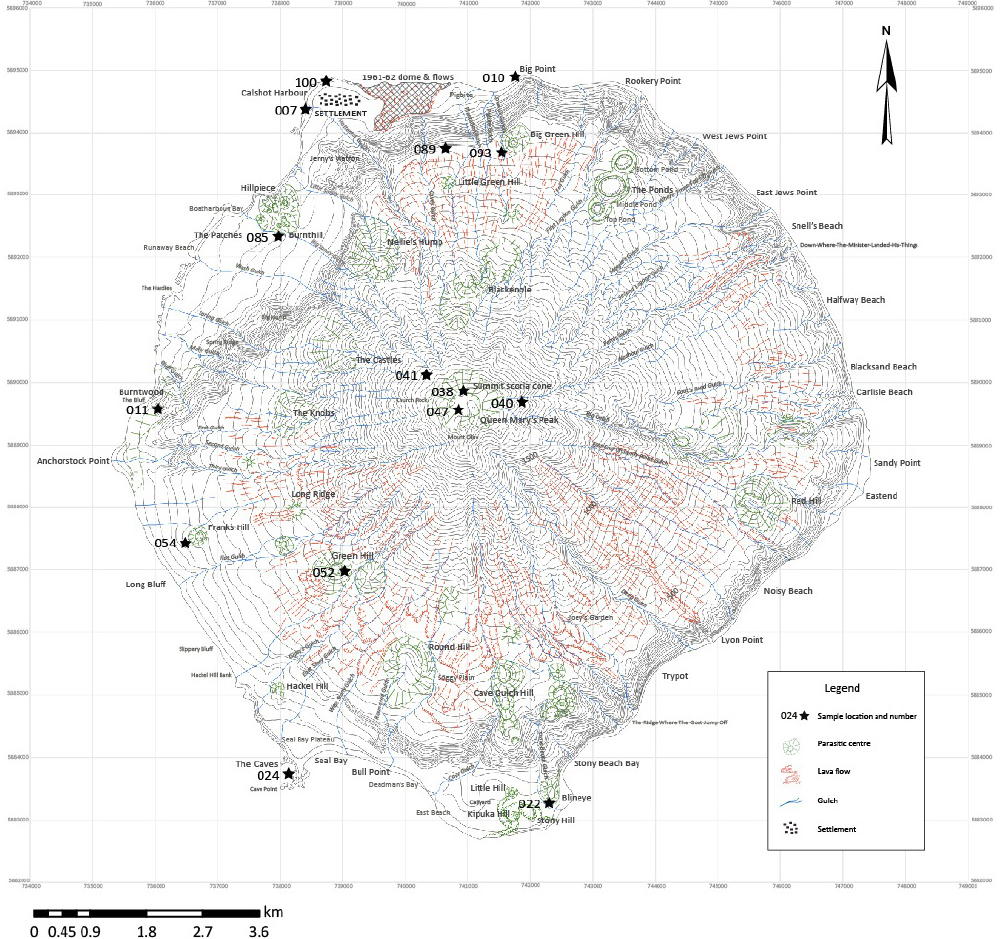
Figure 1. Map of Tristan da Cunha including sampling sites for 40 Ar / 39 Ar dating. The Settlement is located in the north of the island (modified from Dunkley,